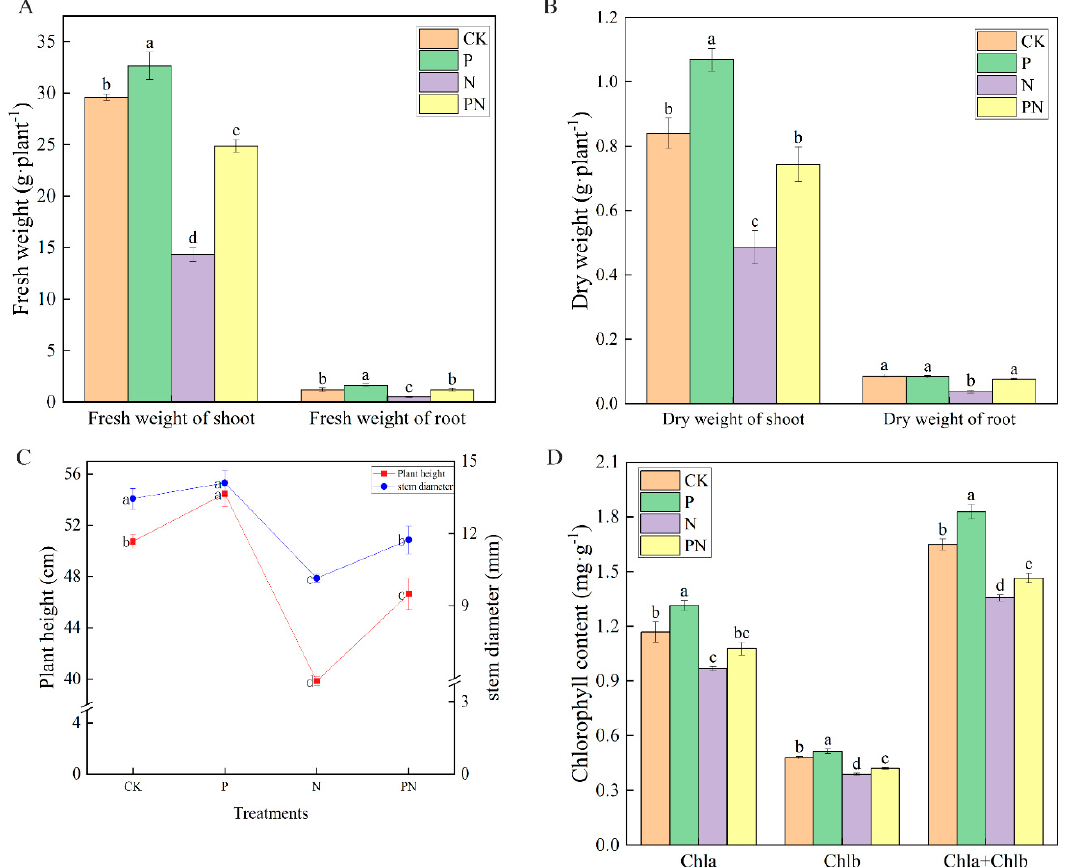
Figure 1. Effect of exogenous proline on celery’s growth and photosynthetic pigment content under salt stress. After planting the 35-day-old seedlings for 7 days, they were treated with 0.3 mM proline solution for 7 days, after which they were watered with 100 mM NaCl solution thrice every 3 days. ( A ) Fresh weight. ( B ) Dry weight. ( C ) Plant height and stem diameter. ( D ) Chlorophyll content. The results are expressed as the mean ± SE of three replicates, and the different letters denote the significant difference among treatments ( p < 0.05), according to Duncan’s multiple tests. CK, control. P, 0.3 mM proline. N, 100 mM NaCl. PN, 100 mM NaCl+ 0.3 mM proline.